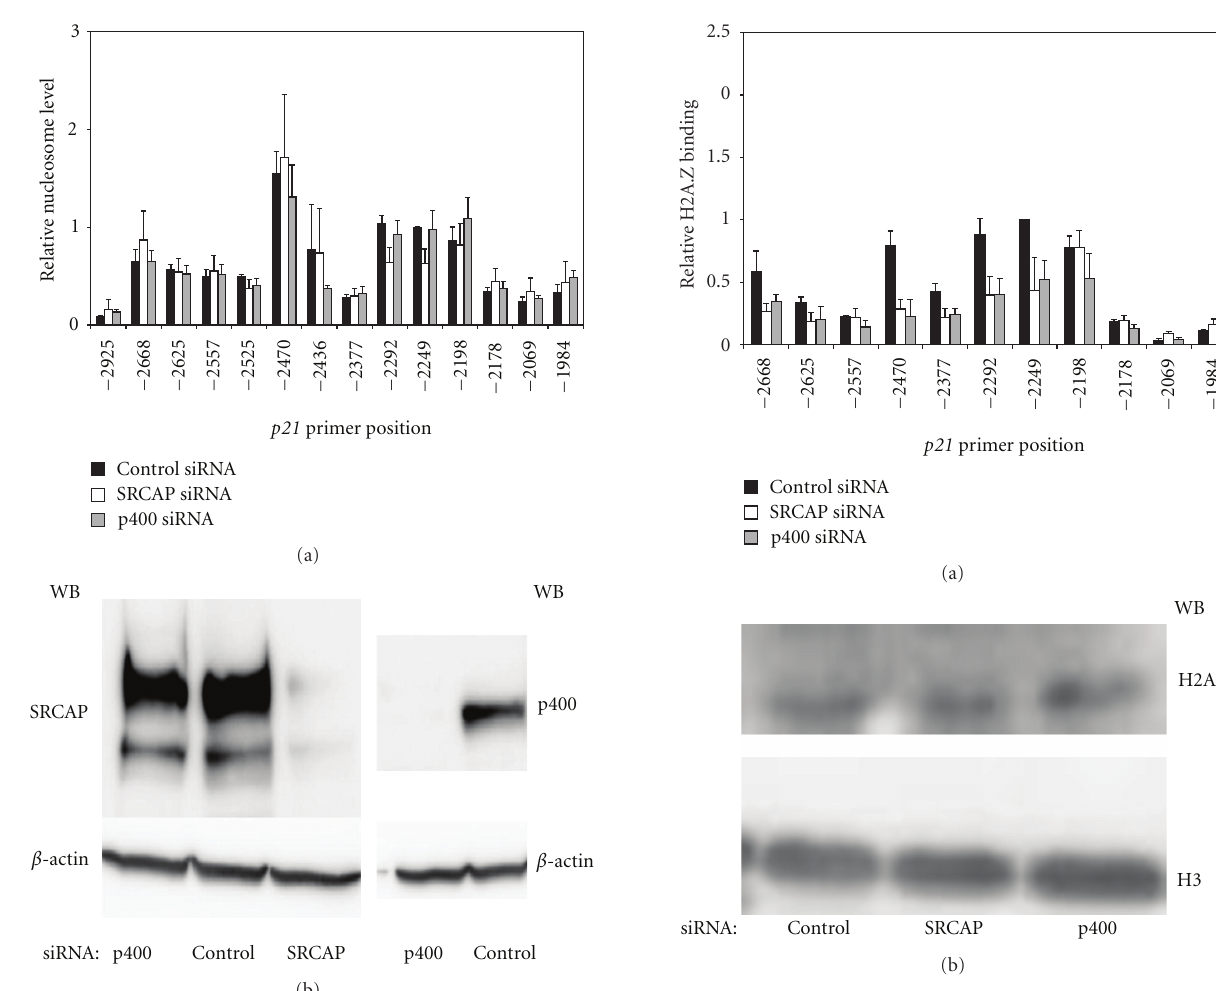
Figure 2: Knockdown of SRCAP or p400 decreases H2A.Z depo- sition into p21 promoter nucleosomes. A549 cells were transfected with control, SRCAP or p400 siRNA and harvested 72 hours later. In (a), nucleosome ChIP assays were performed using anti-H2A.Z antibody and immunoprecipitated DNA was amplified by qPCR using the indicated primer sets (see Table S1(c)). The amount of DNA amplified at each position is presented relative to the amount of DNA amplified at position − 2249. The graph represents the mean result and standard error of three or more independent ChIP experiments. In (b), histones were acid-extracted and protein levels were determined by Western blot analysis using anti-H2A.Z antibody. Histone H3 was used as a loading